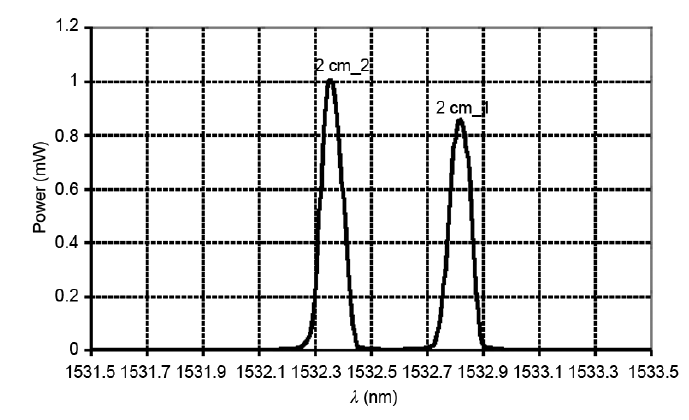
Fig. 4. Emission spectrum of an array of two fiber lasers.